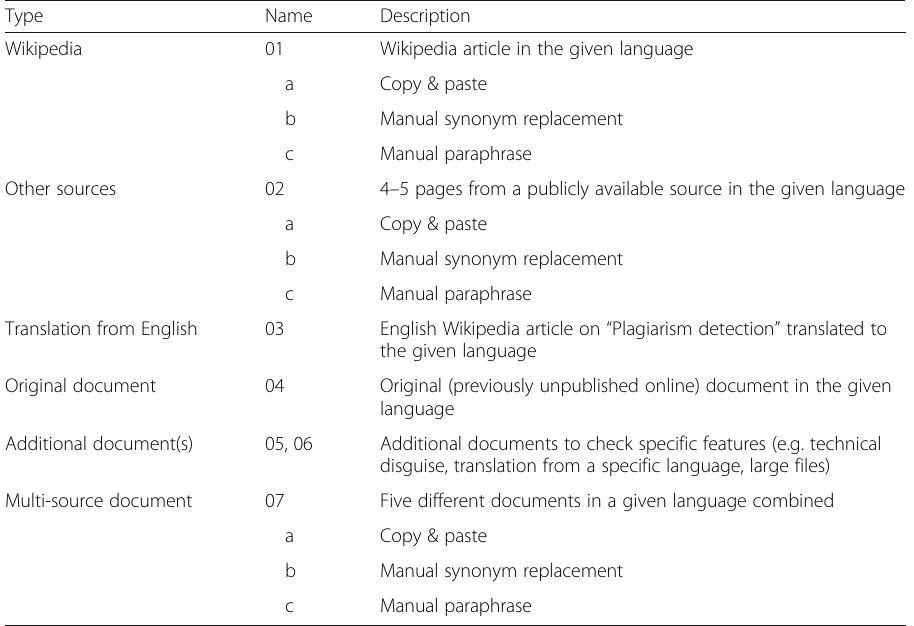
Table 1 Testing documents and naming